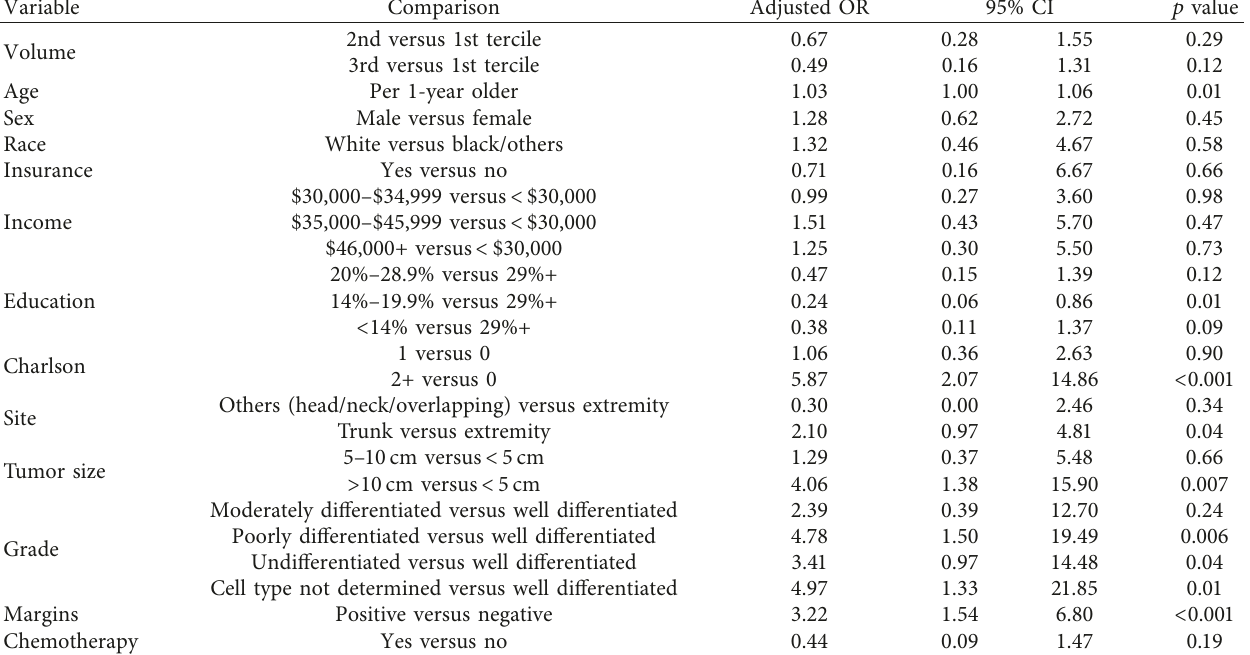
Table 4: Multivariable analysis for 30-day mortality.